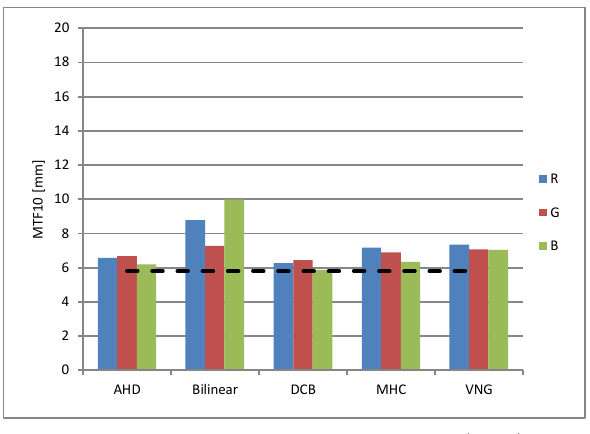
Figure 10: Determined